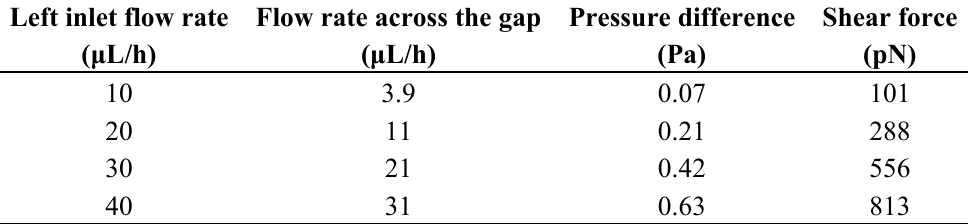
Table 1. Calculations of the pressure difference and shear force across docked cells at the